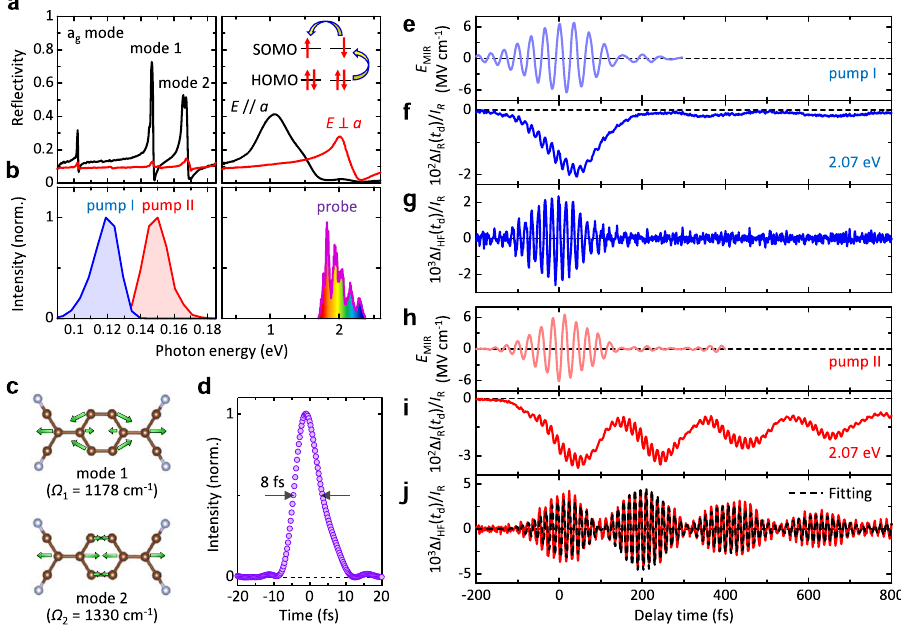
Fig. 2 Optical responses associated with phonon-dressed states generated by a mid-infrared pulse in K-TCNQ. a Polarized re fl ectivity spectra of K-TCNQ. SOMO and HOMO represent a singly occupied molecular orbital and a highest occupied molecular orbital, respectively. b The spectra of mid- infrared pulses for pump I and pump II, and of a visible-probe pulse. c Schematics of atomic motions in a g ν 5 mode with Ω 1 = 1178 cm − 1 and a g ν 4 mode with Ω = 1330 cm − 1 . d The intensity envelope of the visible-probe pulse. e – j The electric- fi eld waveform of the mid-infrared pump pulse ( e , h ), the time 2 characteristic of the optical response, Δ I R ð t d Þ = I R , at 2.07 eV ( f , i ), and the time characteristic of the high-frequency oscillatory component ( g , j ) for ( e , f ) off-resonant excitation (pump I) and ( h – j ) resonant excitation of a g mode vibrations (pump II). The black broken line shown in j indicates the fi tting